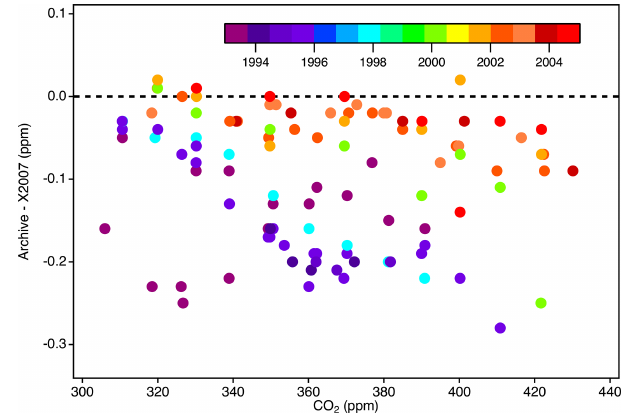
Figure 16. Estimates of scale conversion bias (linear scale conver- sion minus full reprocessing) derived from in situ measurements at four NOAA observatories, global averages determined from mea- surements of discrete air samples collected at marine boundary layer sites (gray line), and two numerical experiments (orange and blue lines; see text). All error bars are 1 standard deviation. Numerical experimental results are shown as 3-year running means.